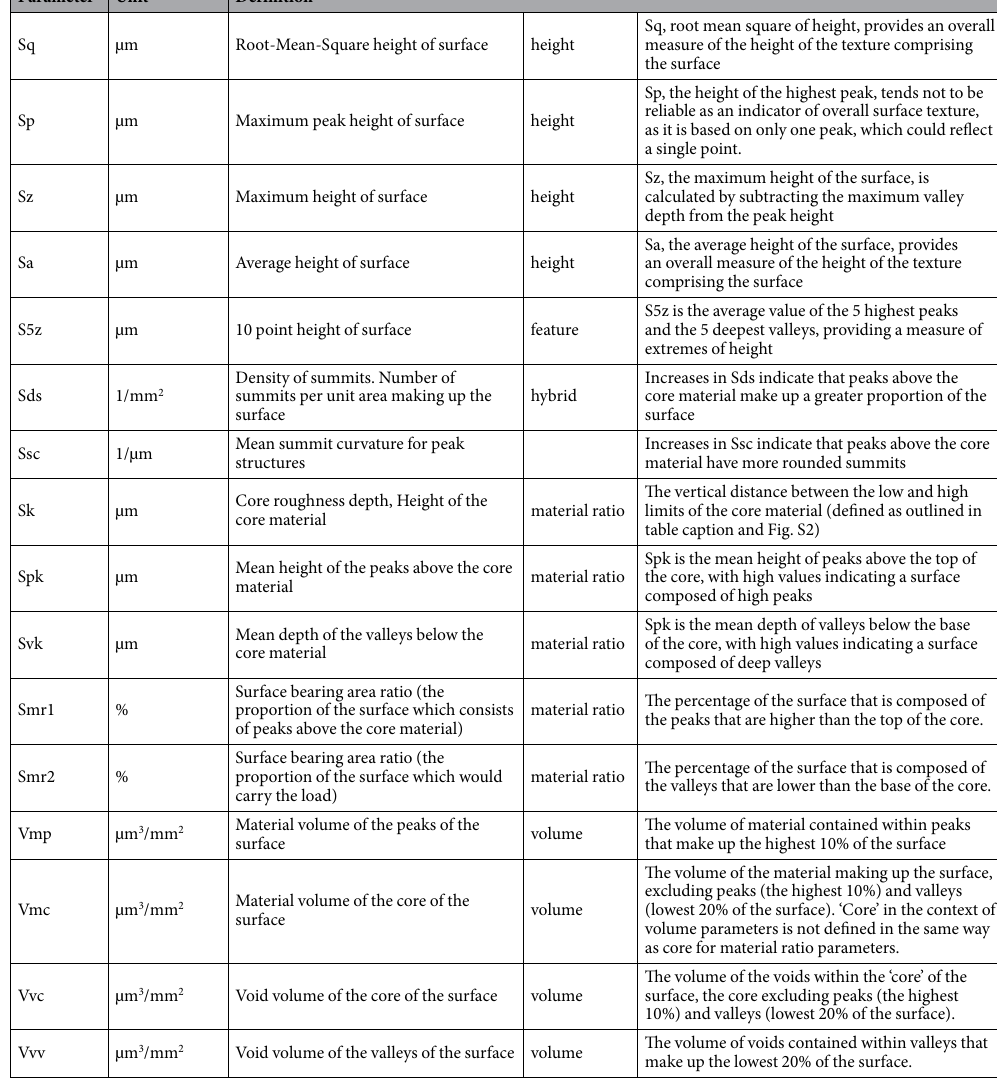
Table 1. Definition, description, and categorization of the International Organisation for Standardisation (ISO) 3D texture parameters that correlate with PC axes. Many parameters are derived from the areal material ratio curve; a cumulative probability density function derived from the scale-limited tooth surface by plotting the cumulative percentage of the tooth surface against height. Fig. S2 provides a graphical explanation. The peaks, valleys and core material of tooth surfaces are defined on the basis of this curve: parts of the surface that are higher or lower than the core are defined as peaks and valleys respectively. A full listing of parameter definitions is provided in Table